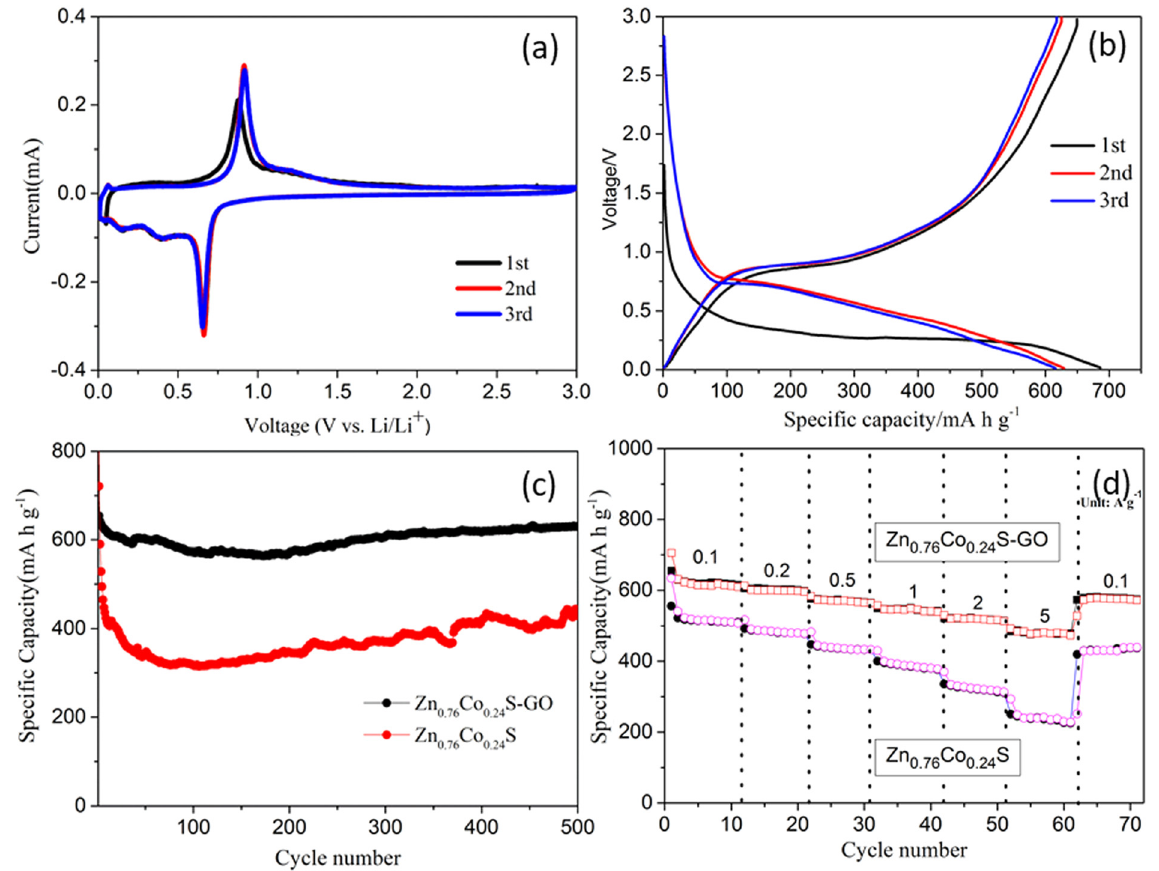
Figure 6: Electrochemical performance of Zn 0.76 Co 0.24 S@N/S - rGO as anodes for SIBs ( a ) CV curves of Zn 0.76 Co 0.24 S@N/S - rGO electrode at a scan rate of 0.1 mV s − 1 within a potential range of 0.01 – 3.0 V ( vs Na/Na + ) . ( b ) Discharge/charge voltage curves of the with Zn 0.76 Co 0.24 S@N/ S - rGO electrode at a current density of 1 A g − 1 . ( c ) Cycling performance at current density of 1 A g − 1 . ( d ) Rate